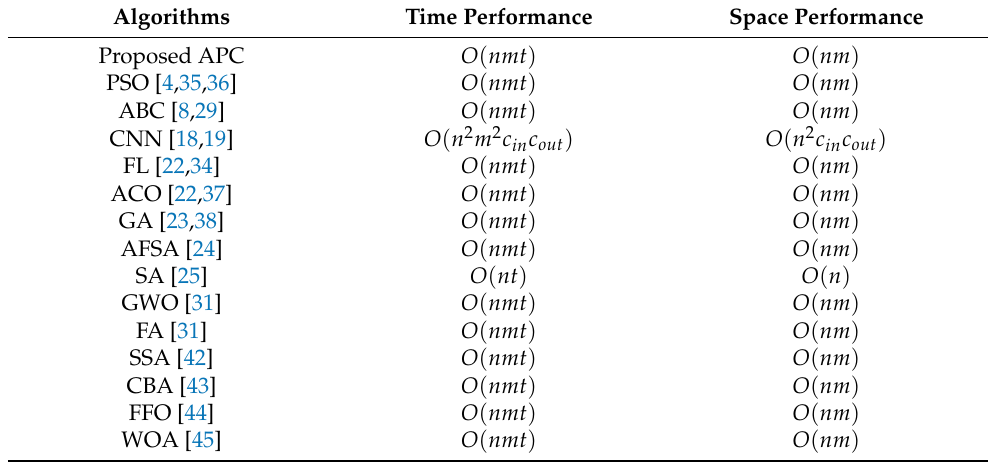
Table 6. Theoretical comparison of time and space